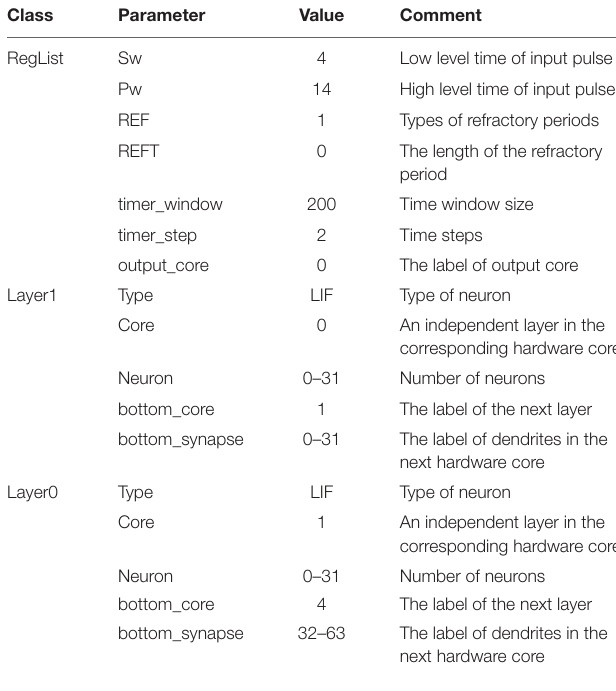
TABLE 1 | Configuration list of